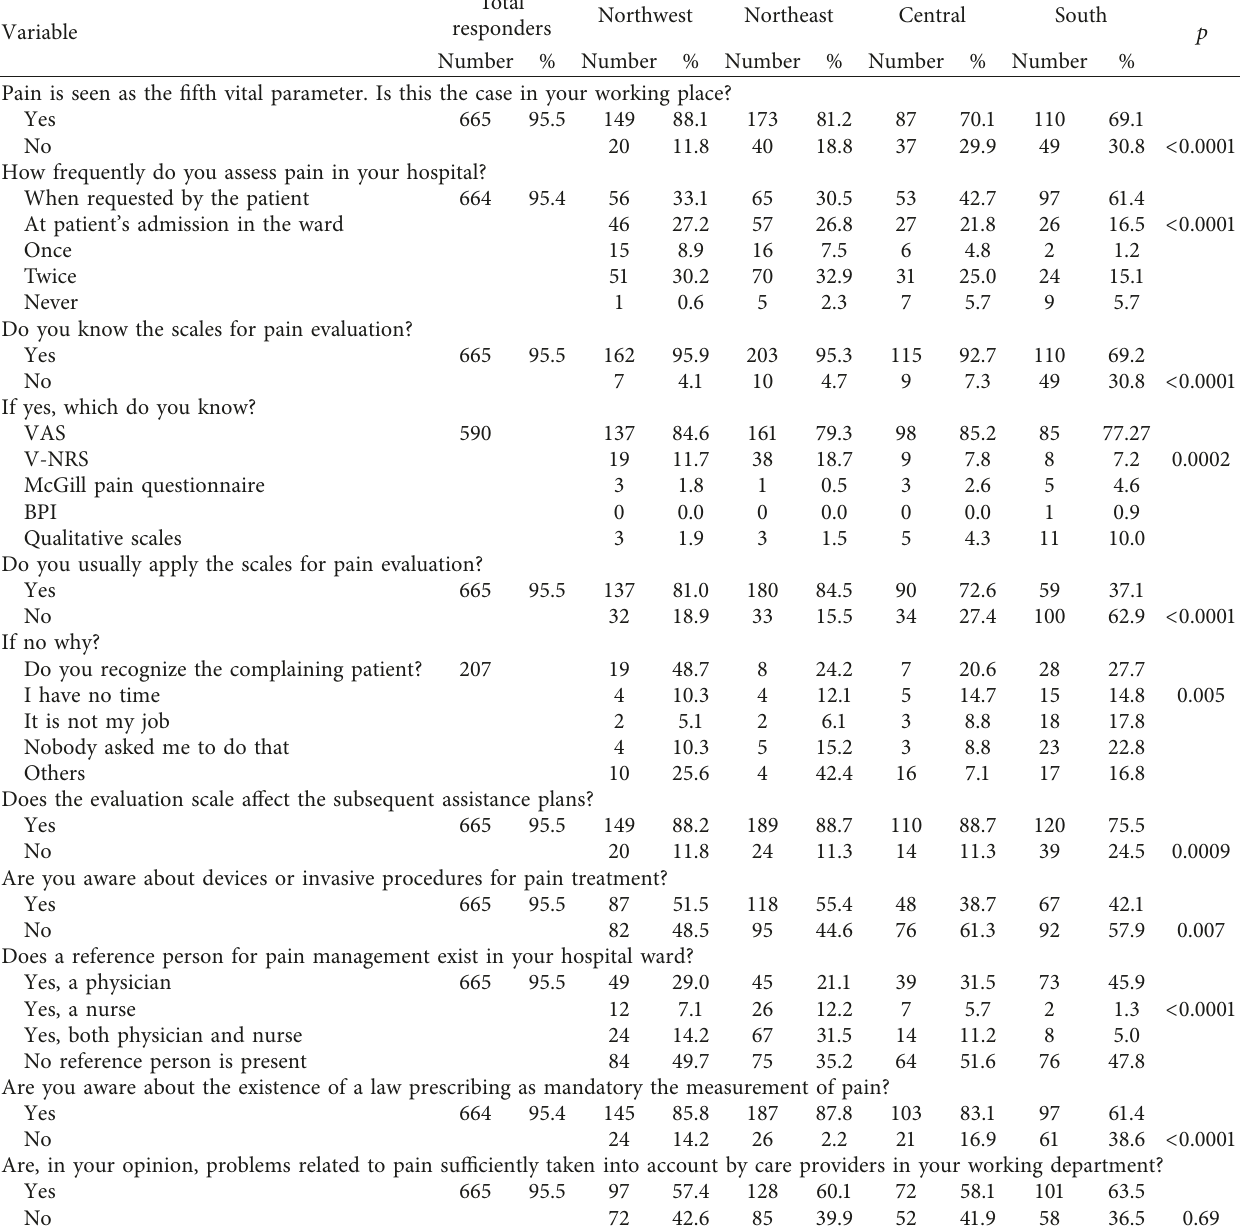
Table 2: Evaluation of pain according to geographic